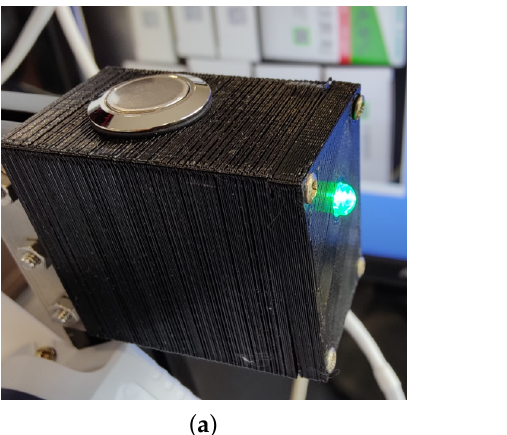
Figure 6. The start of the process order is made by a pushbutton: ( a ) green indicates that the system is available to start a new process; ( b ) red shows that the system is searching and decoding Data Matrix code.